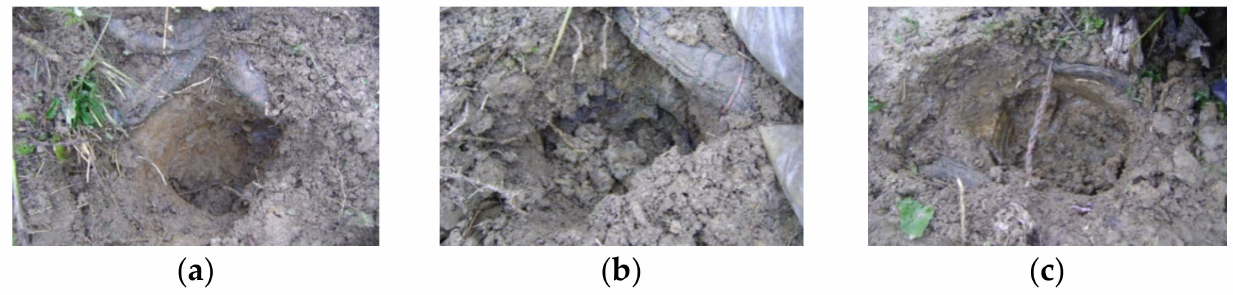
Figure 4. Sampling on 22 October 2017. Detail of the soil sample locations: ( a ) Location 1; ( b ) location 2; ( c ) location 3